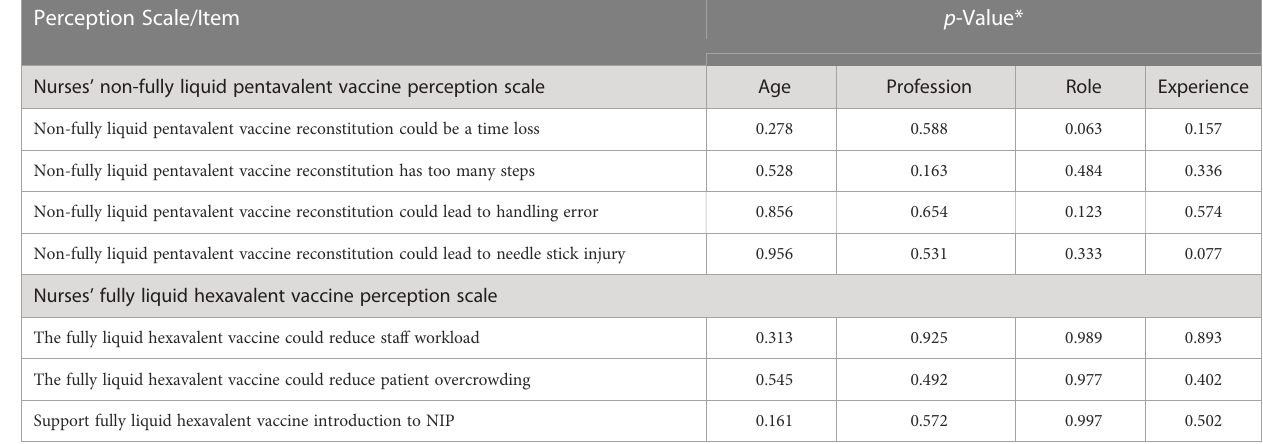
TABLE 3 Factors associated with nurses ’ non-fully liquid pentavalent and fully liquid hexavalent vaccine perception ( n = 100). Perception Scale/Item